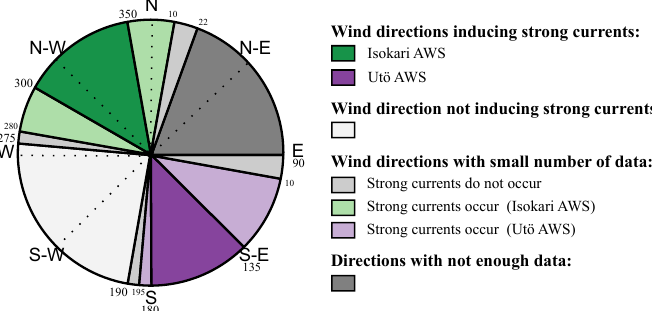
Figure 11. Wind directions distributed to the sectors according to their capability to induce strong currents at Lövskär